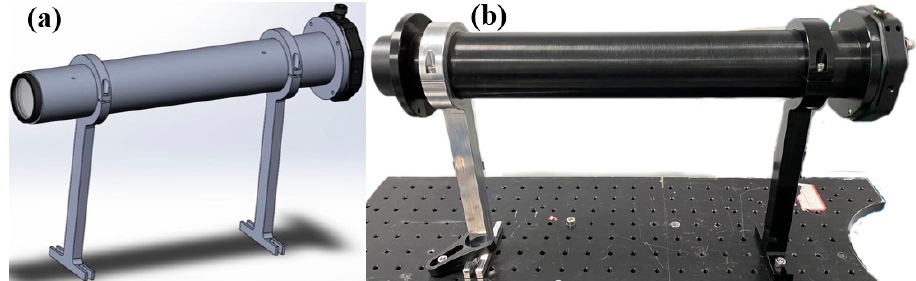
Figure 10. Schematic of the Laser beam expander. ( a ) Design ( b ) Solid.